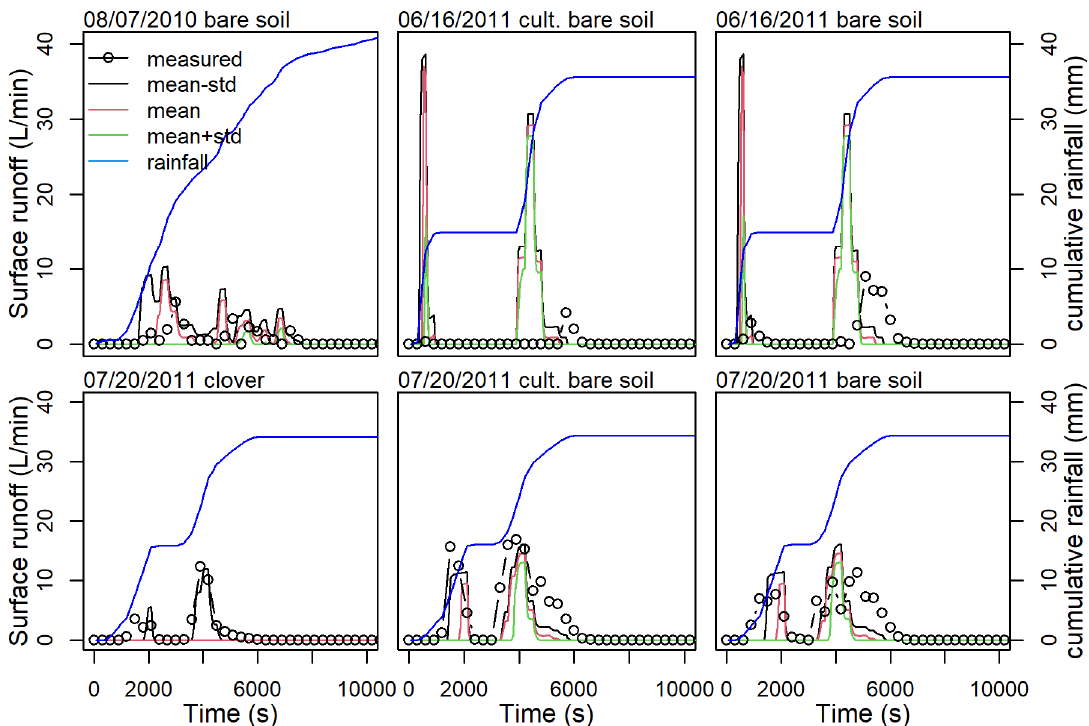
Figure 6. The panel shows the simulations at the RUSLE long-term monitoring plot. Table 3. The correlation coefficient and Nash–Sutcliffe efficiency (NSE) between the modelled surface runoff and the measured surface runoff.